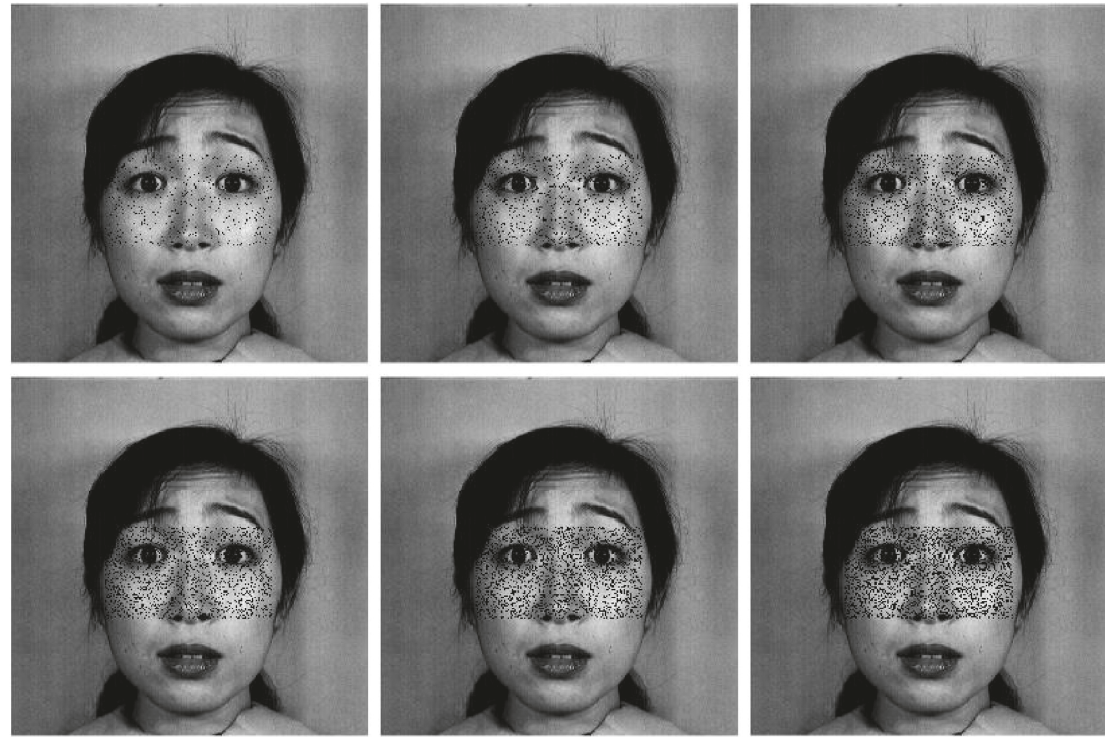
Figure 3: Sample test data with missing values